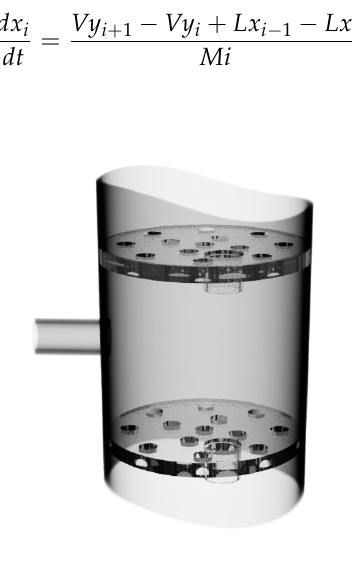
Figure 4. Plates in the column